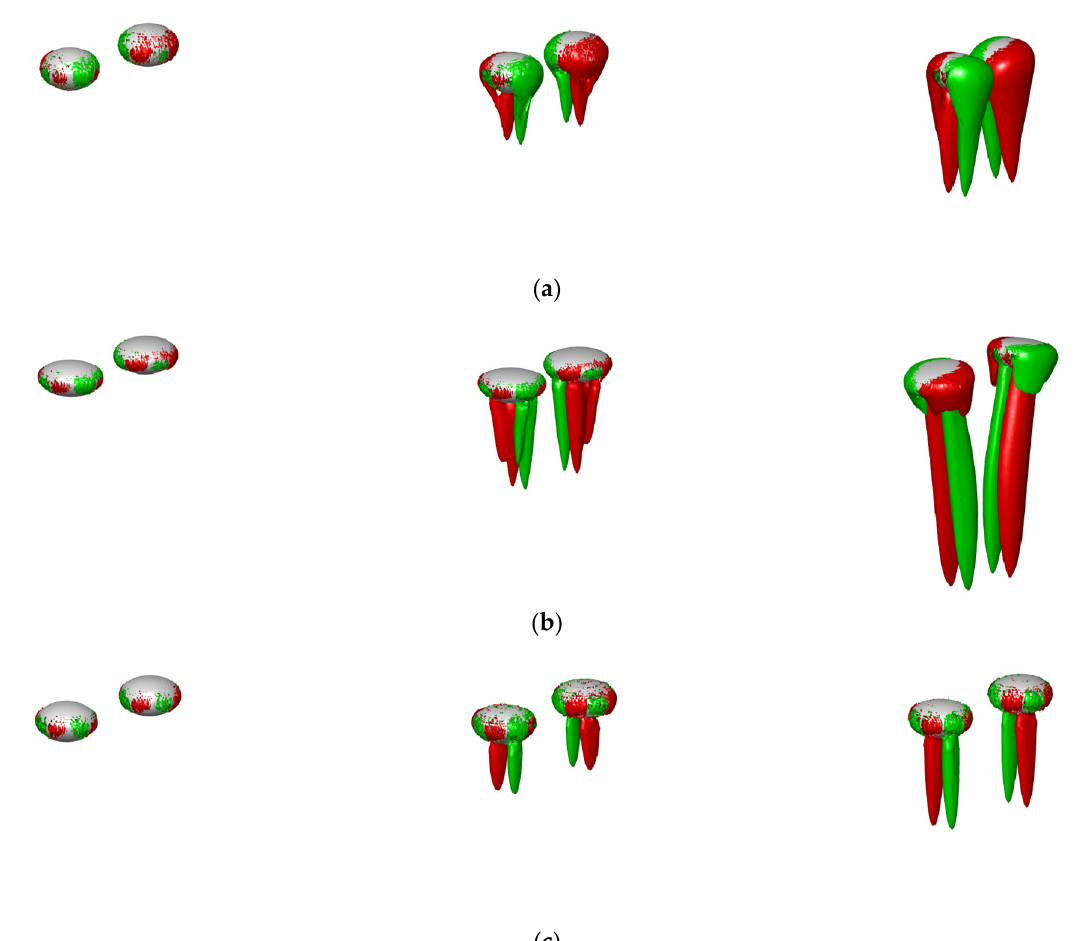
Figure 11. Streamwise vorticity of interacting bubbles: behavior is ( a ) attracting bubbles, ( b ) repelling bubbles, and ( c ) weak repelling bubbles. Green and red vorticity isosurfaces are ( a ) ω z = ± 0.15, ( b ) ω z = ± 0.3 and ( c ) ω z = ± 0.1. Double-threaded wakes are behind bubbles, and trend is same in all